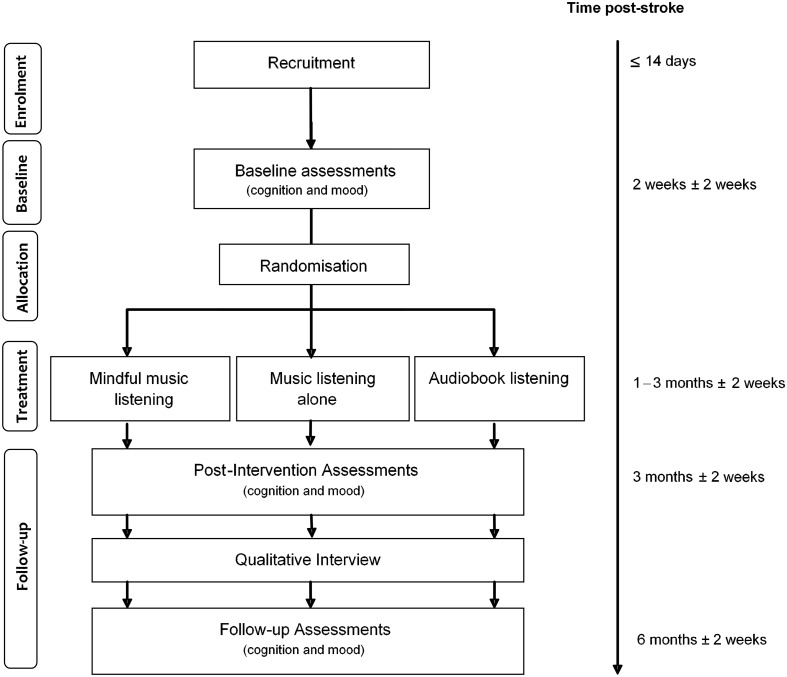
Participant flow.